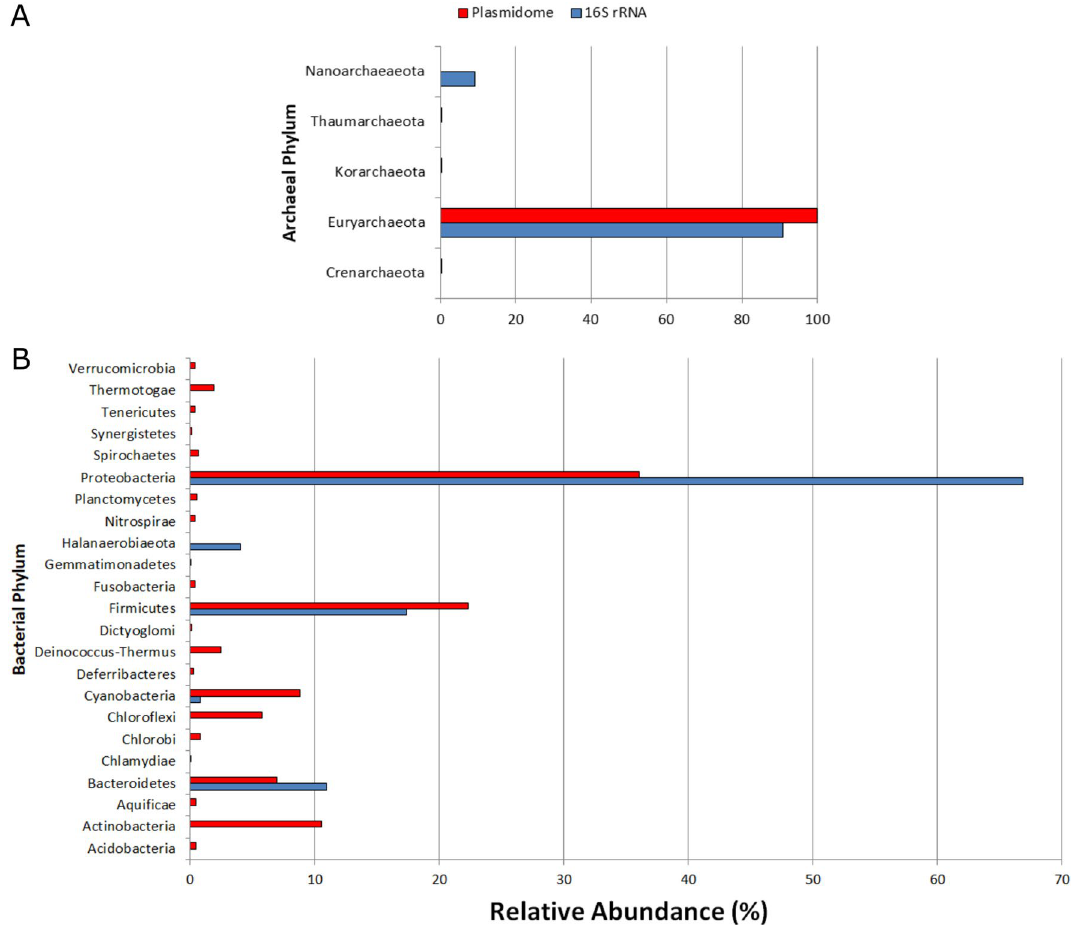
Figure 7. Red biofilm taxonomic analysis from Diamante Lake. Red bars show the relative abundance of each archaeal ( A ) or bacterial ( B ) phylum in the plasmidome by MG-RAST analysis using similarity to the RefSeq database ( E -value ≤ 10 –5 ). Blue bars show the relative abundance of each archaeal ( A ) or bacterial ( B ) phylum by metagenomic DNA analysis using 16S rRNA gene amplicon sequencing. Phyla with abundance less than 1% in both datasets were not